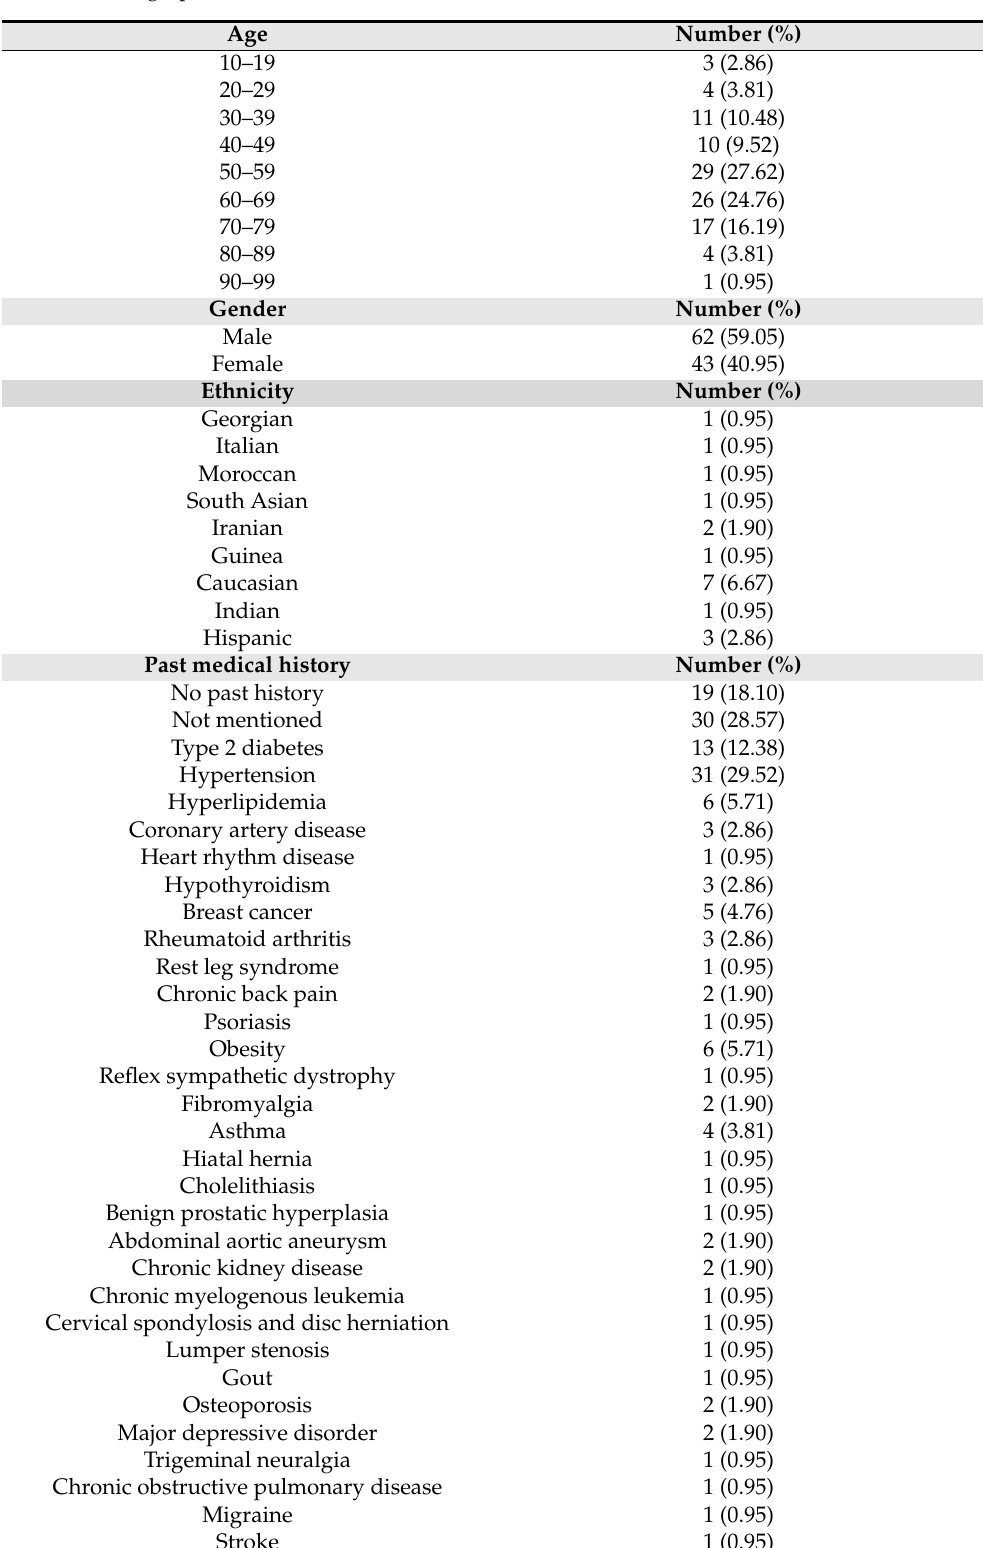
Table 2. Demographic